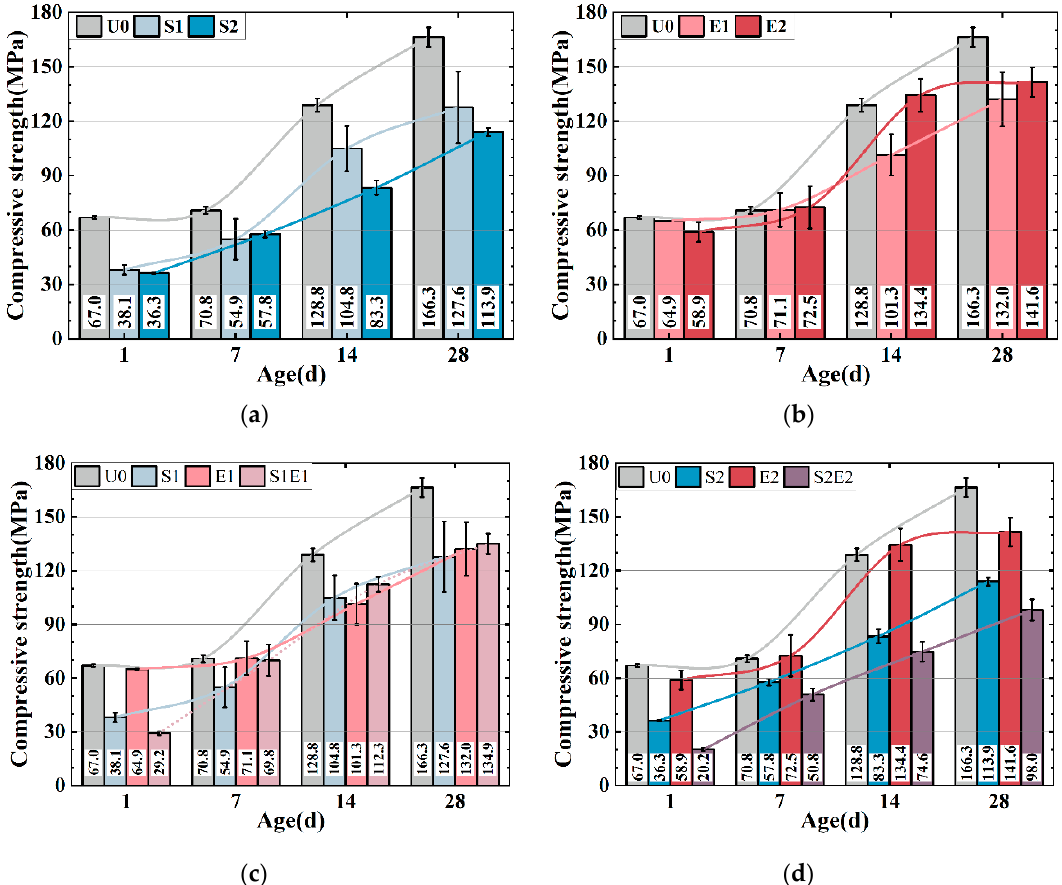
Figure 3. Compressive strength of the UHPC with SAP and CEA. ( a )SAP series; ( b ) CEA series; ( c ) S1E1 series; ( d ) S2E2 series.